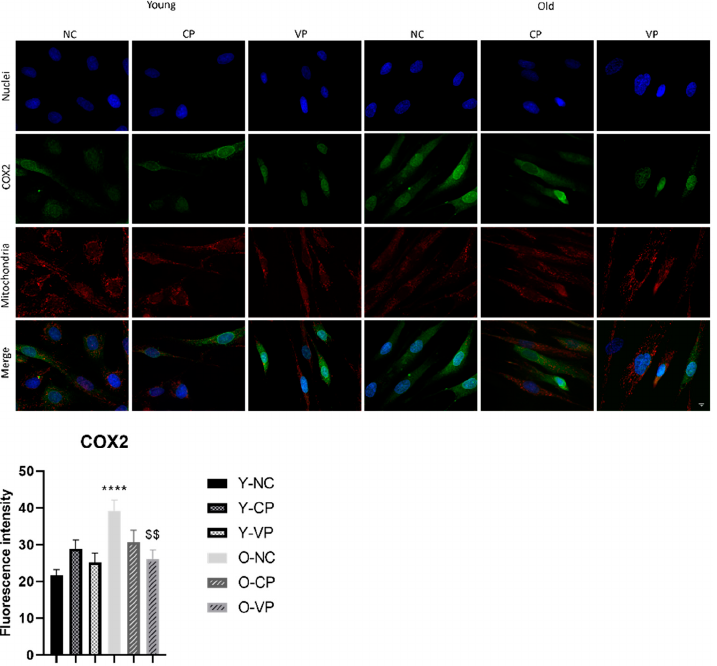
Figure 7. Double immunolabeling for Aco2 (green fluorescence) and mitochondria (red fluorescence); DNA was stained with Hoechst 33258 (blue fluorescence). 60× magnification; scale bar: 10 µ m. Histograms represent the analysis of Aco2 fluorescence intensity. Anova one-way test: not statistically significant. Further, COX2 was investigated as an indicator of oxidative stress/inflammation.